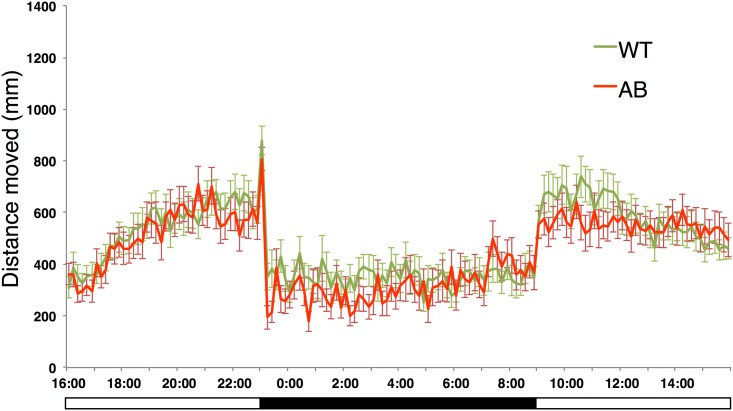
Behavior in double mutant stxbp1as3000/+
stxbp1bs3001/+ larvae.Graph of distance traveled per ten-minute interval by 5dpf wildtype (WT, n = 16) and stxbp1as3000/+
stxbp1bs3001/+ double mutant zebrafish (AB, n = 24) larvae over 24 hours. Mean distance per 10-min interval was 479.3 for WT larvae and 445.4 for AB larvae, significantly different by ANOVA and Tukey post hoc tests (p<0.001) as described in the main text.